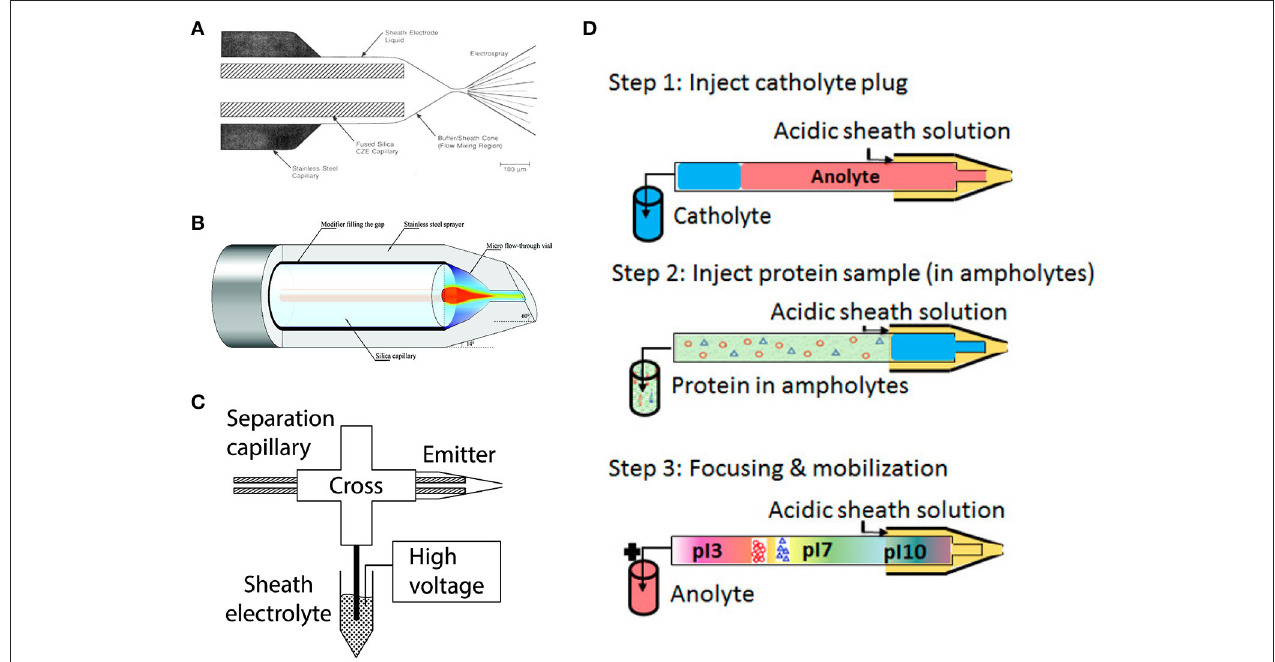
FIGURE 1 | (A) Coaxial sheath flow interface. Reproduced with permission from Smith et al. (1988). Copyright 1988 American Chemical Society. (B) Flow-through microvial interface. Reproduced with permission from Zhong et al. (2011a). Copyright 2011 American Chemical Society. (C) Electrokinetically pumped sheath flow interface. Reproduced with permission from Sun et al. (2015). Copyright 2015 American Chemical Society. (D) Flowchart of automated cIEF-MS. Reproduced with permission from Dai et al. (2018). Copyright 2018 American Chemical